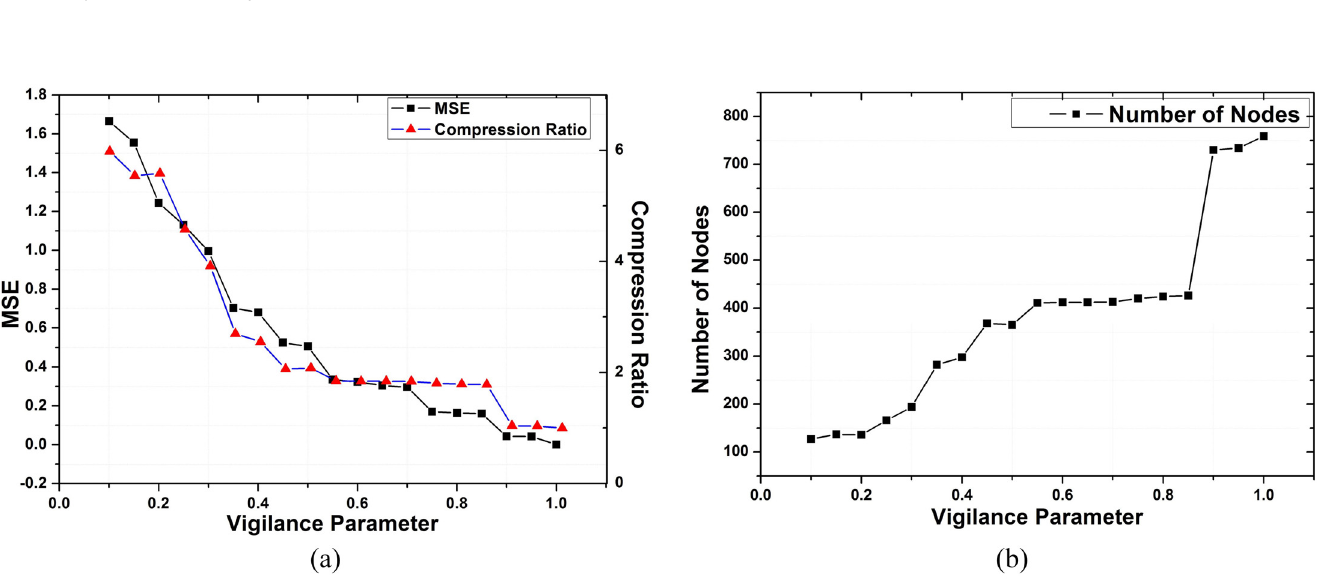
Fig 13. (a) Plot for compression ratio and average mean square error for different values of vigilance parameter. (b) Effect of different values of vigilance parameter on the number of nodes.